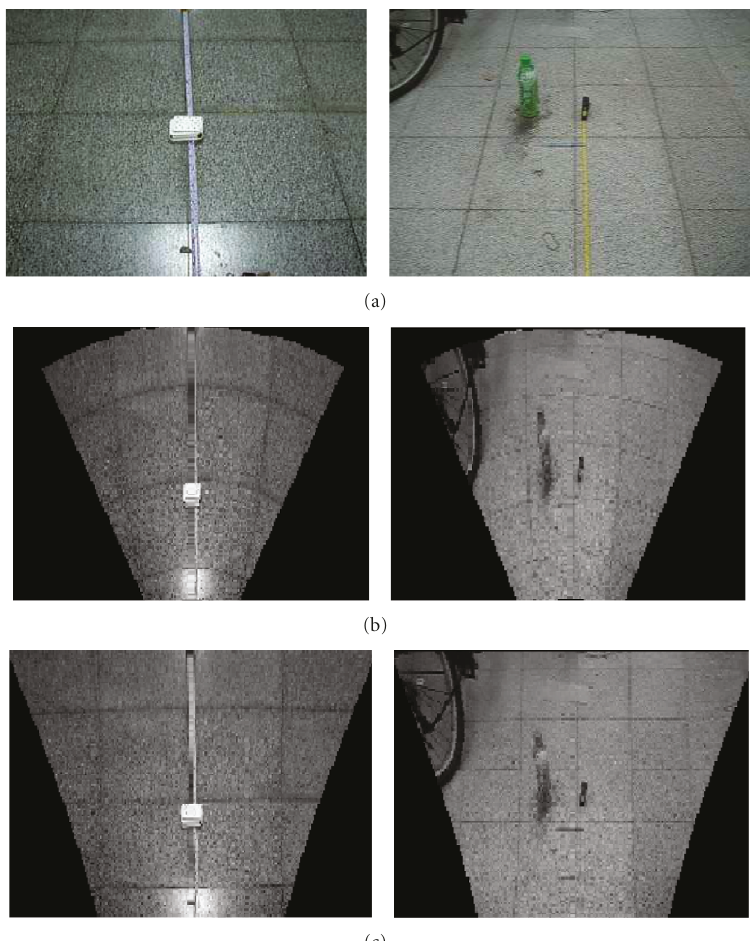
Figure 19: The results of the normal lens IPM equations (a) the original captured image (b) the bird-view image using Broggi’s equations (c) the bird-view image using our equations.